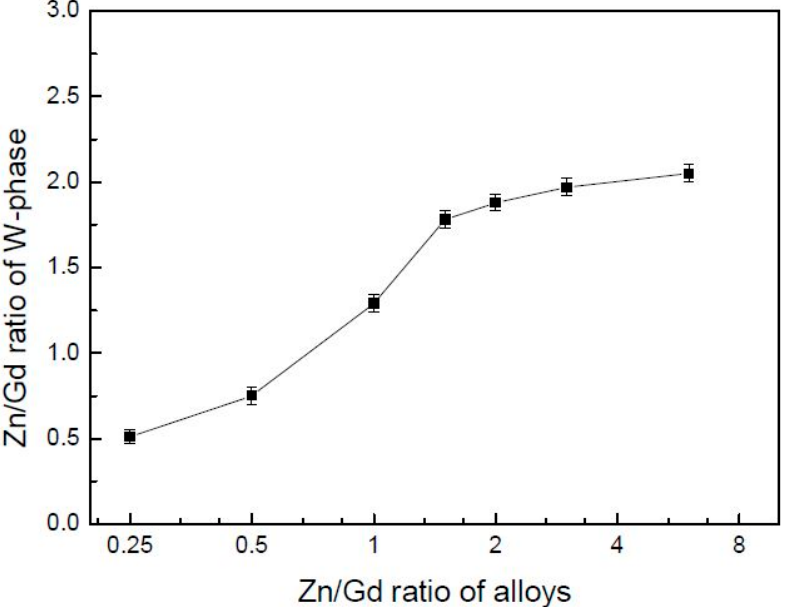
Figure 8. The Zn/Gd ratio in W-phase plotted as a function of Zn/Gd ratio in alloys (Zn/Gd ratio in alloys range from 0.25 to 6, sample 45, 35, 28, 21, 18, 5, 6). Table 3. The mean values of a W-phase in Mg-Zn-Gd alloys through 2 θ of peaks in X-ray diffraction (XRD) patterns (Zn/Gd ratio in alloys range from 0.25 to 6). Alloys (Zn/Gd Ratio)